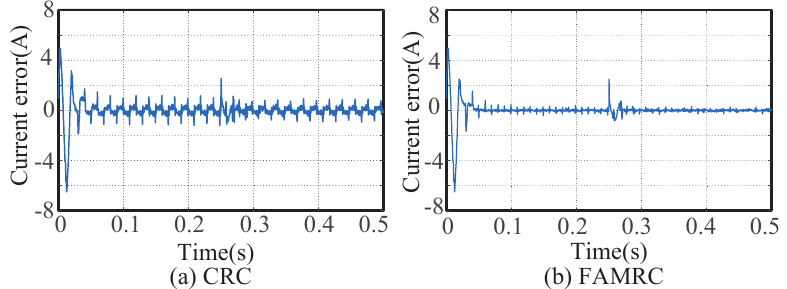
Figure 13. Current error of two control systems with grid frequency fluctuation ( f g = 50.4